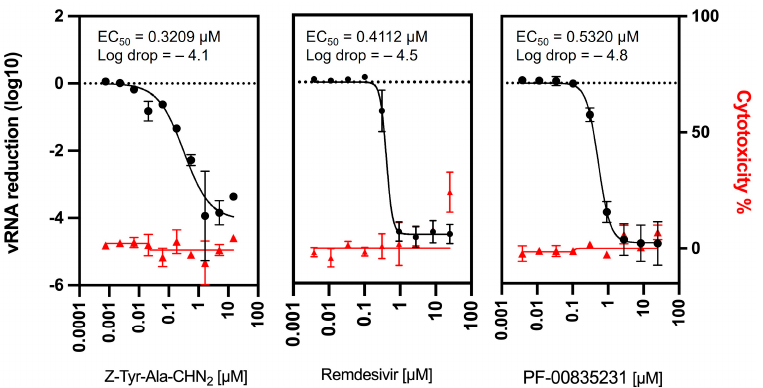
Figure 2. Comparison of viral RNA reduction in the supernatant of SARS-CoV-2-infected A549- hACE2 cells using Z-Tyr-Ala-CHN 2 ( n = 2), remdesivir ( n = 3), and PF-00835231 ( n = 3). Toxicity was determined using ATPlite on uninfected A549-hACE2 cells and is based on two independent experiments. No significant differences ( p < 0.05) in compound potency and log drop were observed using Welch’s unpaired t testing (assuming normality of data).